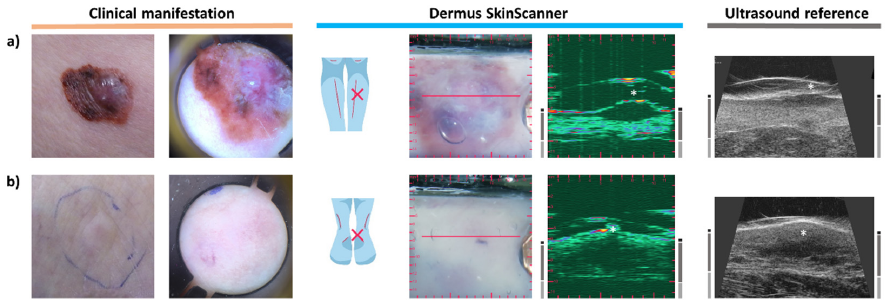
Figure 4. Examination images of a melanoma and of a cutaneous metastasis of melanoma (see Figure 2 for figure layout information). ( a ) The ultrasound images of the melanoma lesion show the characteristic hypoechoic spindle-like depth morphology affecting the epidermal and dermal regions. ( b ) In the case of melanoma metastasis, no characteristic features can be observed in the